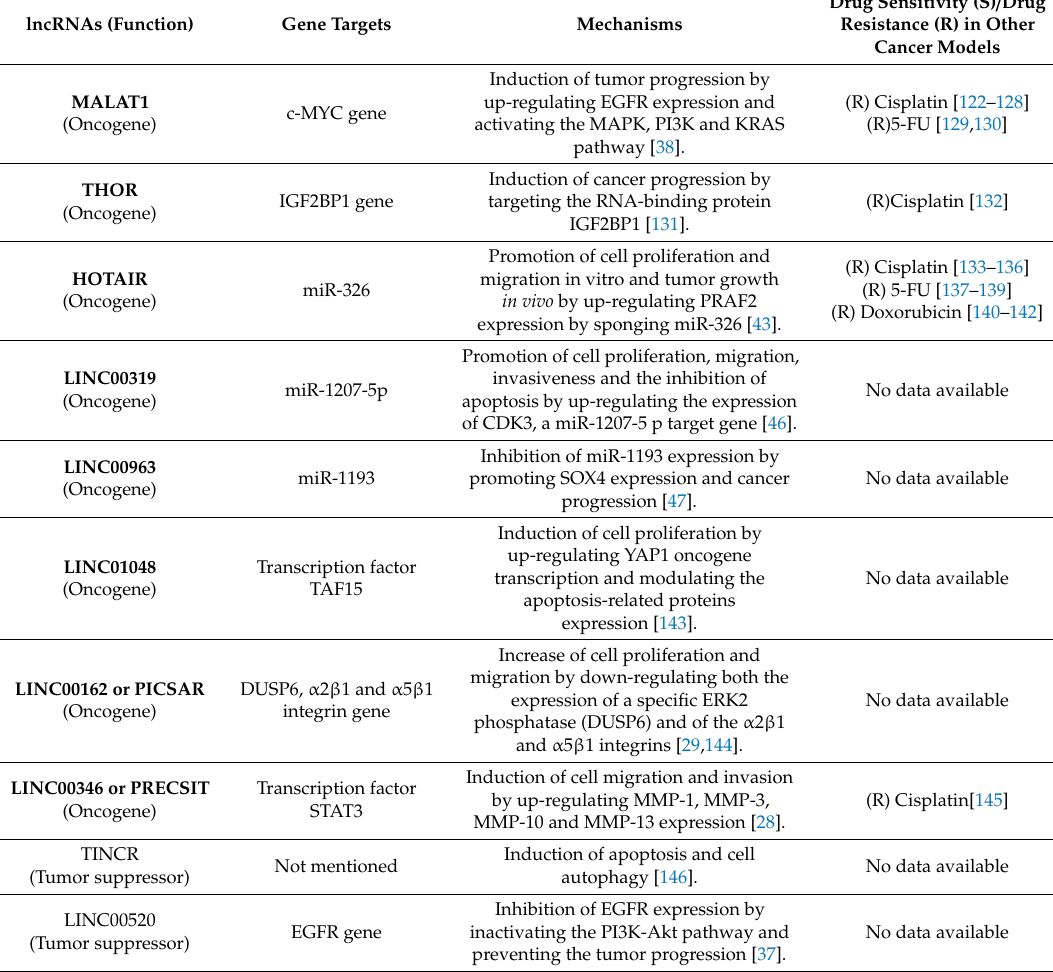
Table 3. Up-regulated (in bold) and down-regulated (normal letters) lncRNAs in CSCC. lncRNAs (Function) Gene Targets Mechanisms